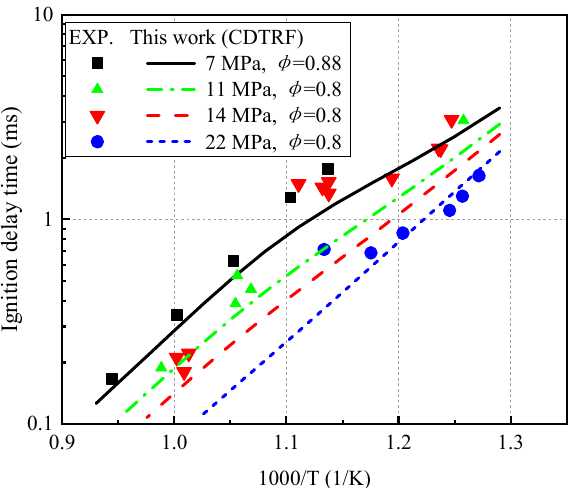
Figure 15. Comparison of ignition delay time between gasoline mixture experiment and model calculation under high pressure.